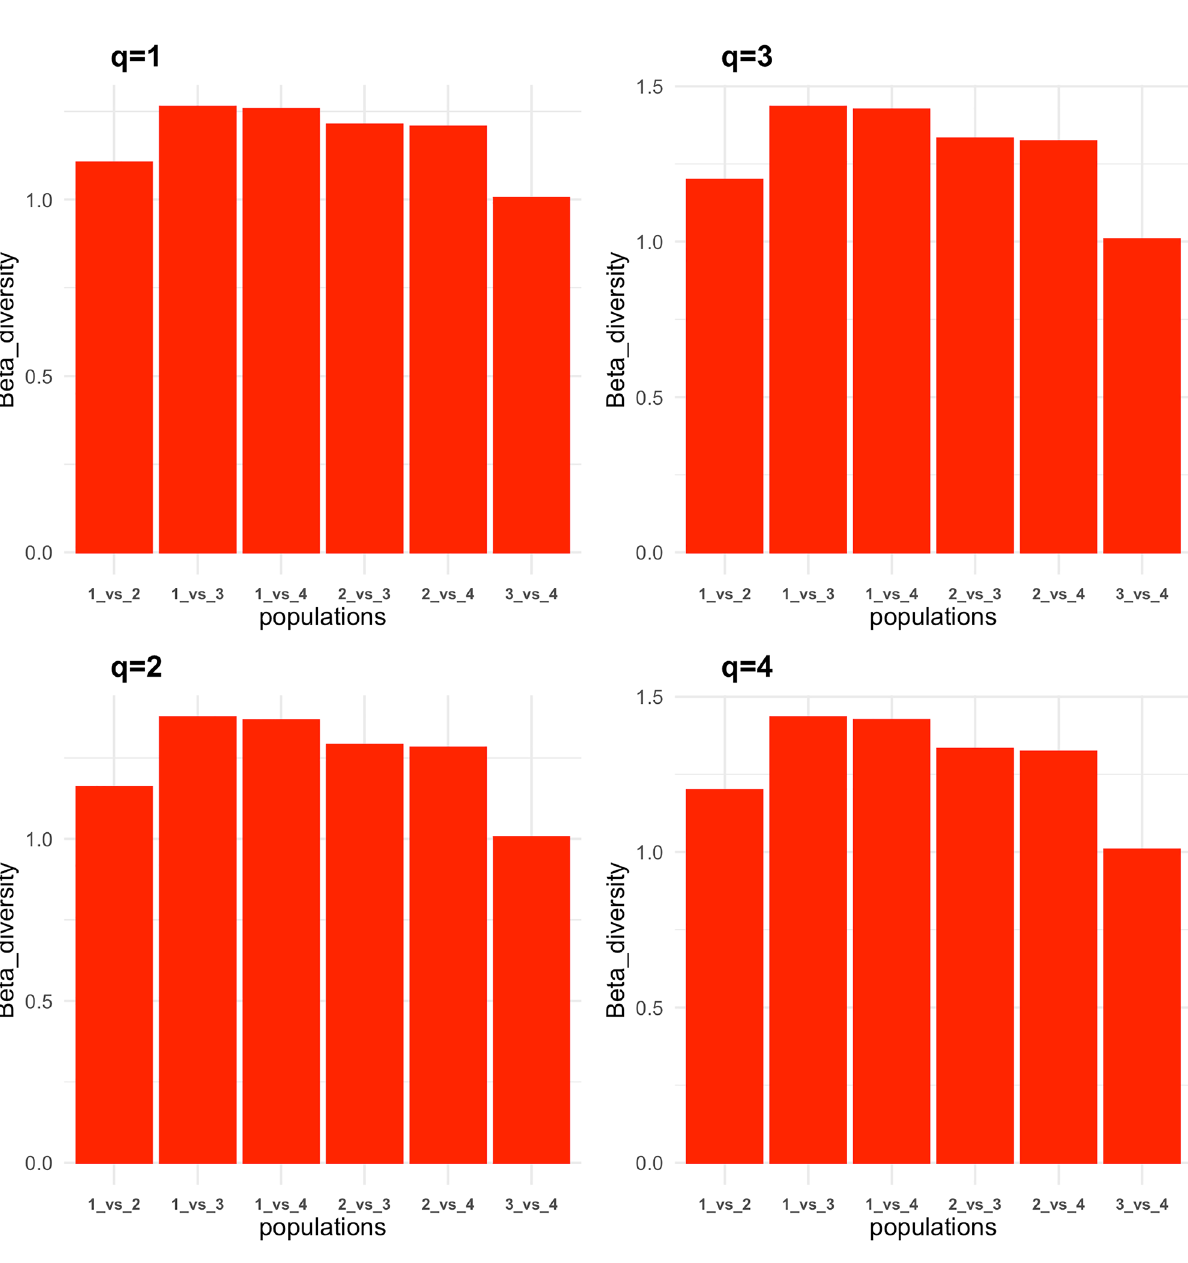
Figure 4. Average autosomal beta diversity at diversity orders q = 1 to 4. Populations: (1) Arabian Peninsula dromedary camels; (2) dromedary camels from Iran; (3) Bactrian camels from Iran; and (4) Bactrian camels from